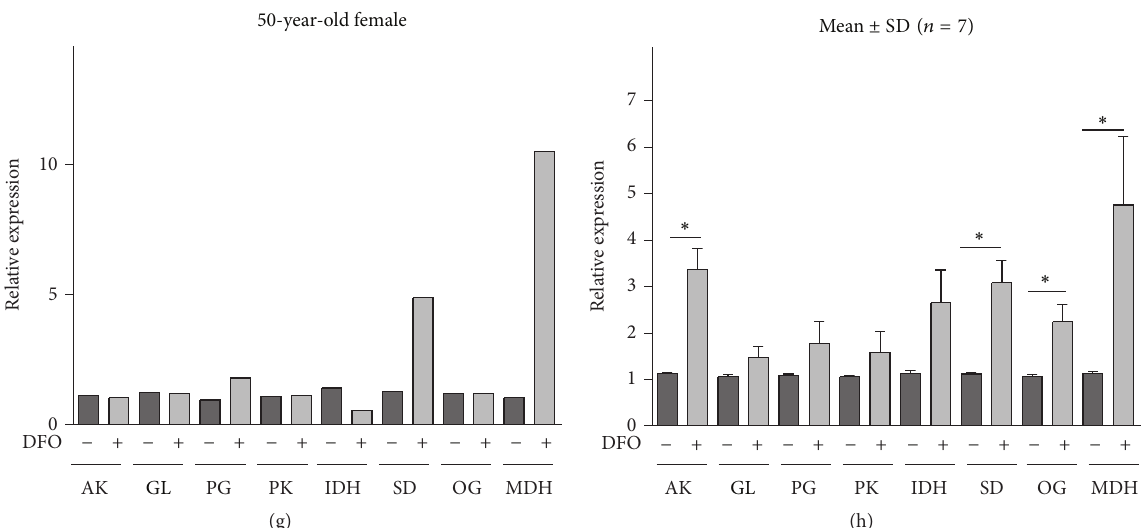
Figure 4: Effects of DFO on the expression of genes responsible for the TCA cycle, glycolysis, and AMPK. Relative gene expression with reference to 𝛽 -actin is compared with controls, as determined by real-time PCR analyses in osteoarthritic cartilage explant cultures in the presence or absence (control) of 10 𝜇 M deferoxamine (DFO) at 48 hours. The means ± SDs for all seven patients (a–g) are shown in (h) (Wilcoxon matched pairs test). Asterisks ( ∗ ) indicate significant differences compared to the control ( 𝑝 < 0.05 ). The age and gender of each patient are indicated. AK, AMPK; GL, Glut1; PG, PGK1; PK, PKM2; IDH, IDH3G; SD, SDH; OG, OGDH; MDH,